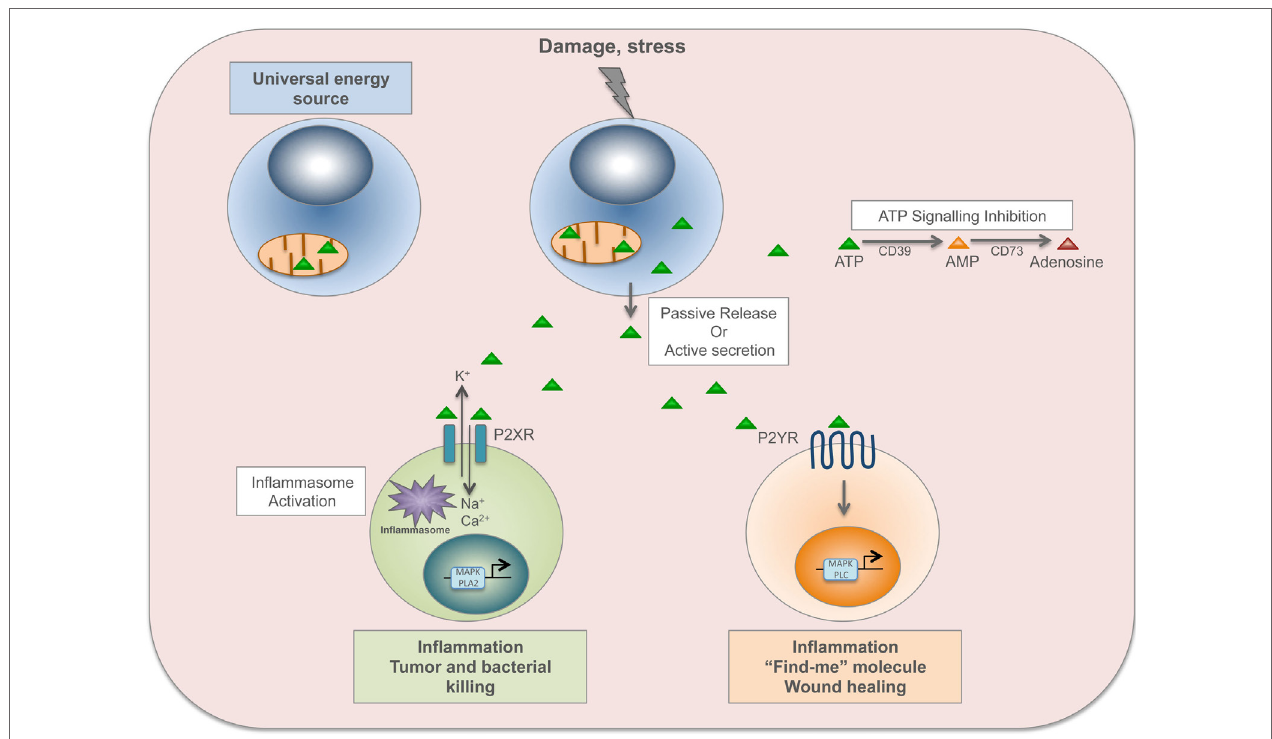
bacterial killing. ATP also binds to metabotropic P2Y receptors (P2YR), which are G-protein-coupled, and induces activation of MAPK and phospholipase C (PLC). P2YR signaling is implicated in inflammation and wound healing, and ATP released by apoptotic cells acts as a “find-me” signal to recruit macrophages to the site of damage and to promote clearance of apoptotic cells. ATP signaling is abolished by the enzymatic conversion of ATP to adenosine through the ecto-nucleoside triphosphate diphosphohydrolase CD39 (from ATP to AMP) and the ecto-5 ′ -nucleotidase CD73 (from AMP to